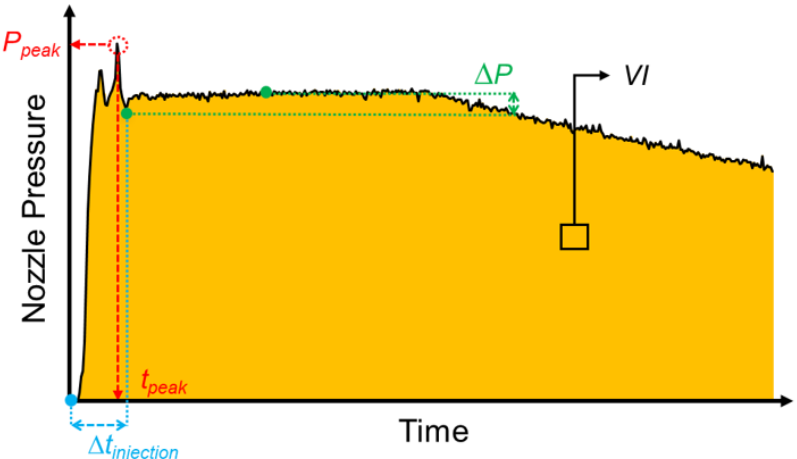
Figure 4. Nozzle pressure profile characteristics.